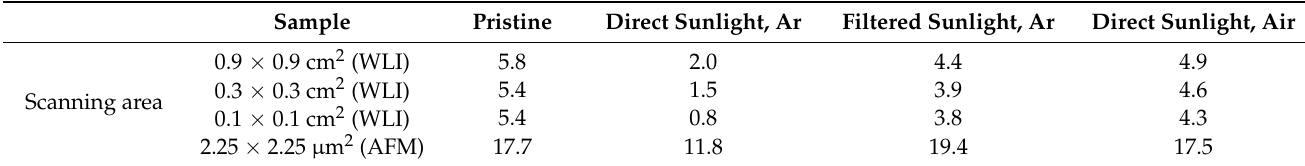
Table 1. Values of Sq, in nm, for the V-metallized surface of SubPzS 3 H 0 films on glass, measured over different scanning areas by WLI and